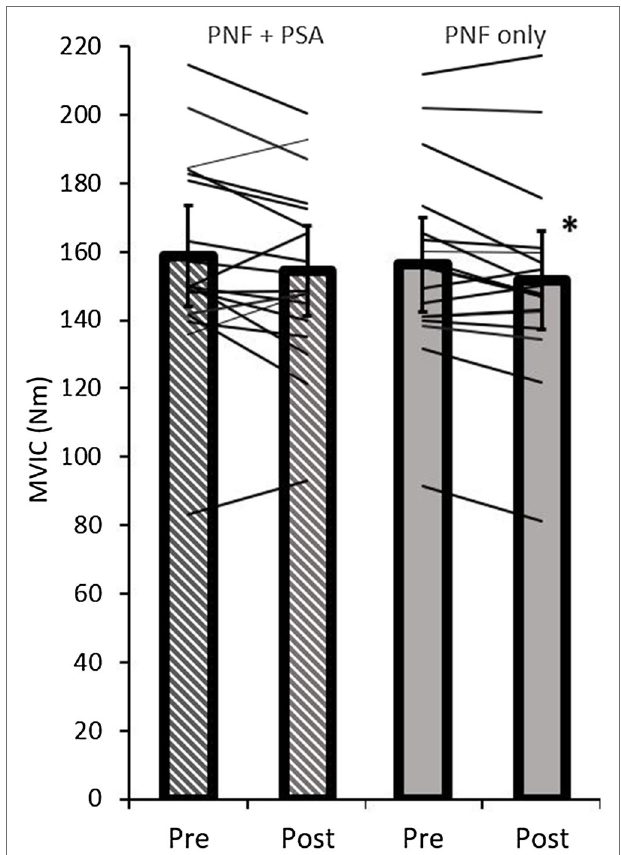
FIGURE 6 | Pre- and post-MVIC peak torque values of both groups (PNF only and PNF + PSA) and the individual changes. * = significant change between pre- and post-values.